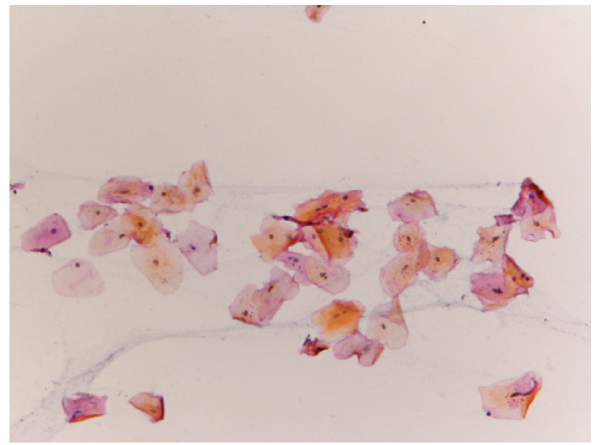
Figure 1. PAP smear evaluation showed the presence of keratinocytes of the upper and medium layer within the brush.